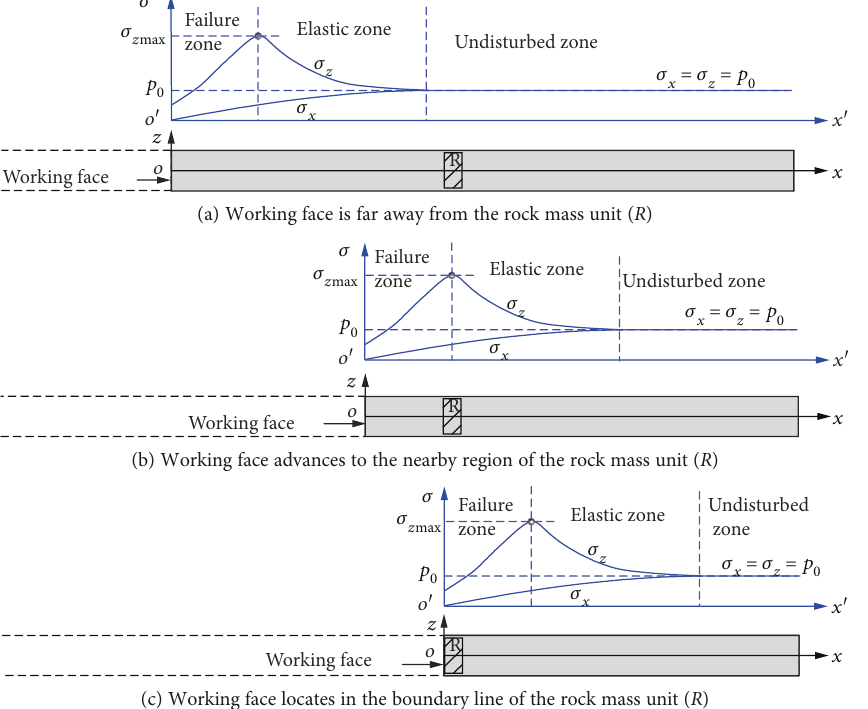
Figure 2: Stress distribution of rock mass ahead of the working face.